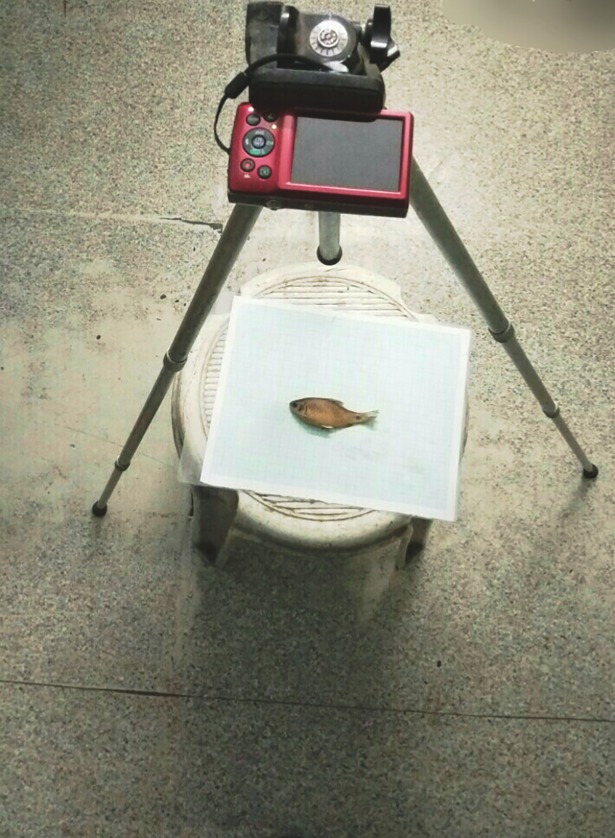
Imaging sample fish on laminated truss sheet for truss morphometrics.